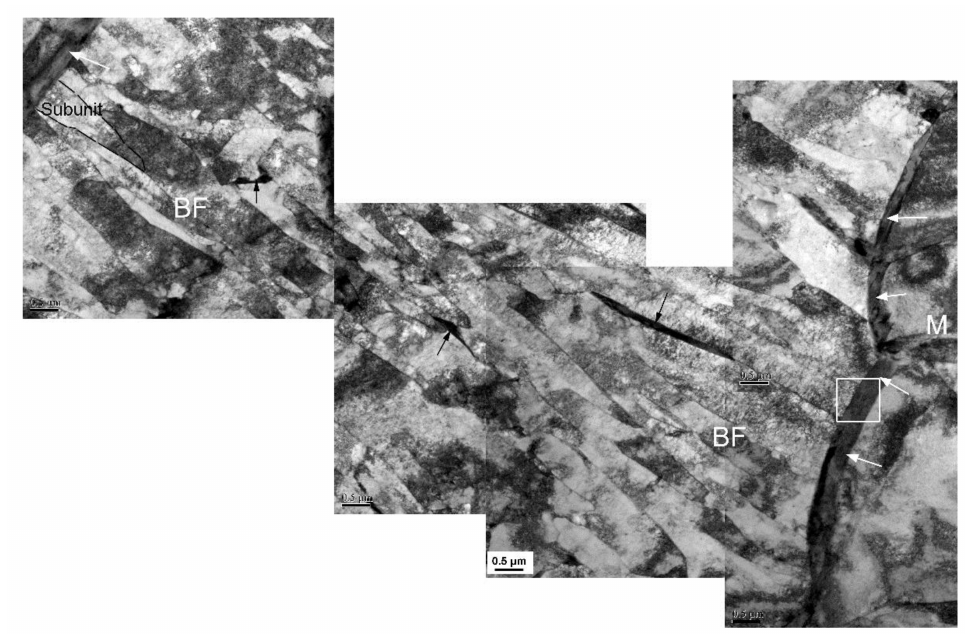
Figure 7. Transmission electron microscope (TEM) images showing the fine structure and grain boundary character of partially transformed microstructure using the same sample of Figure 6d (BF: bainitic ferrite, M: martensite, grain boundary MA constituents are signified with white arrows and fine MA constituents are marked with black arrows).